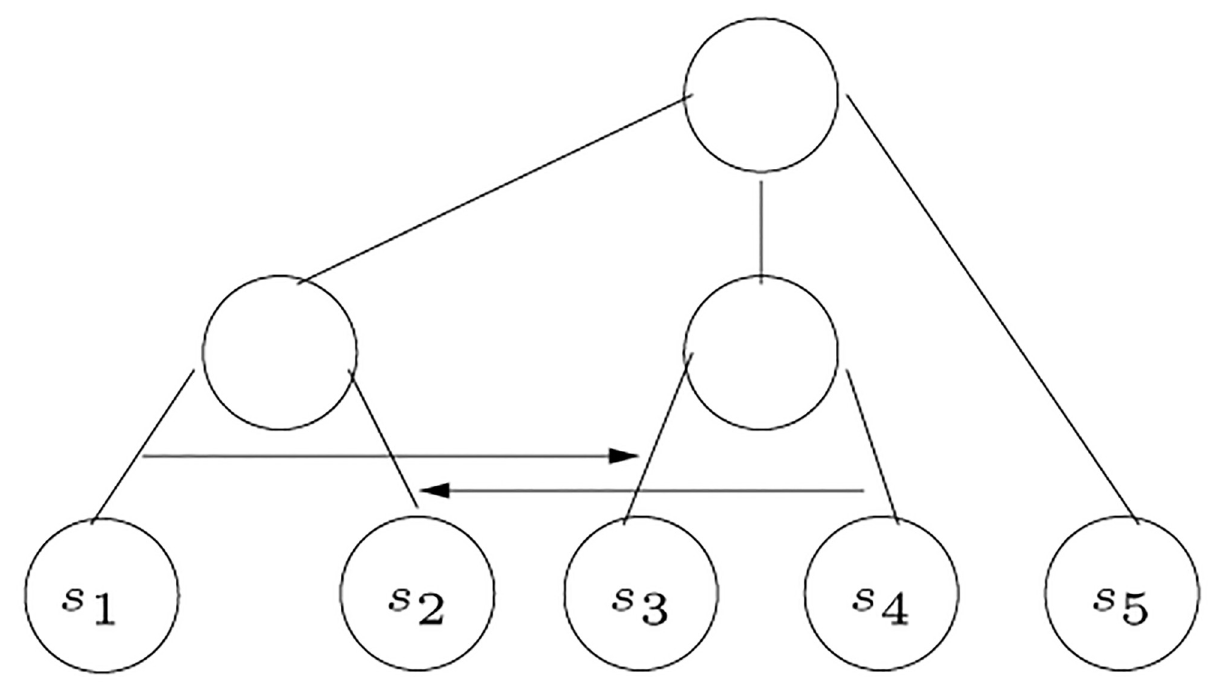
Fig 1. The possible HGT events for the example in Fig